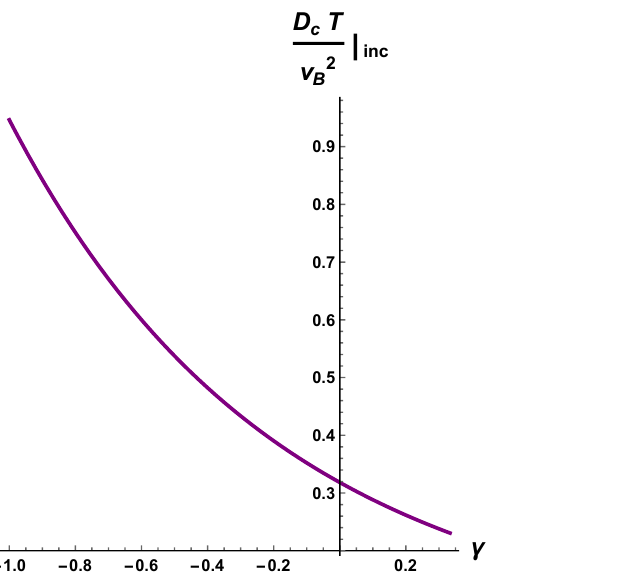
Figure 2 . Charge di(cid:11)usivity in the incoherent limit in function of the Horndeski coupling (cid:13) : (cid:12) D c T (cid:12) (cid:12) v 2 B inc